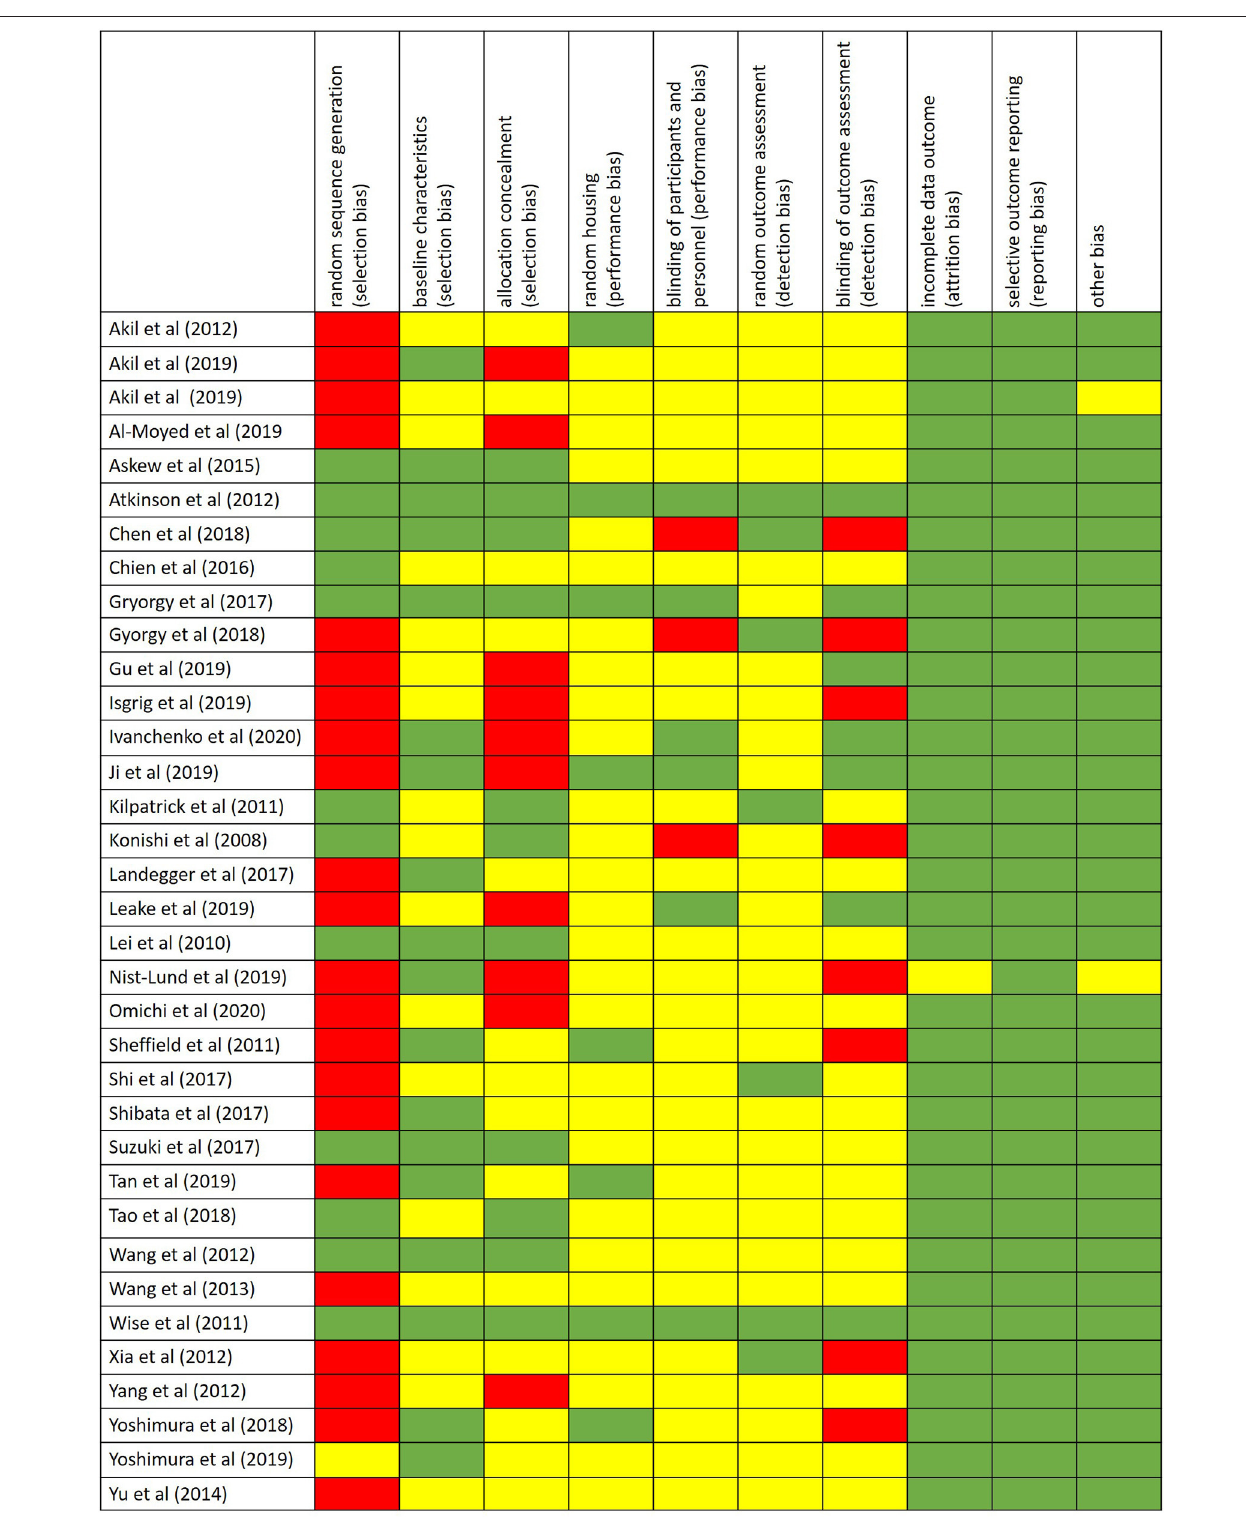
FIGURE 2 | Risk of bias performed by using the SYRCLE’s risk of bias tool for animal studies. Red = high risk of bias; Yellow = unknown risk of bias; Green = low risk of bias.